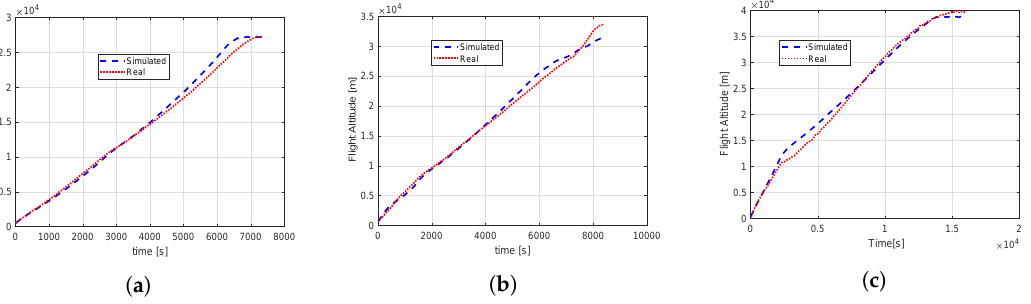
Figure 4. Altitude variation of real and simulated flights for three types of balloons which were launched from Esrange Space Centre: ( a ) 12,000 m 3 (FL-1); ( b ) 50,000 m 3 (FL-2); ( c ) 1,120,546 m 3